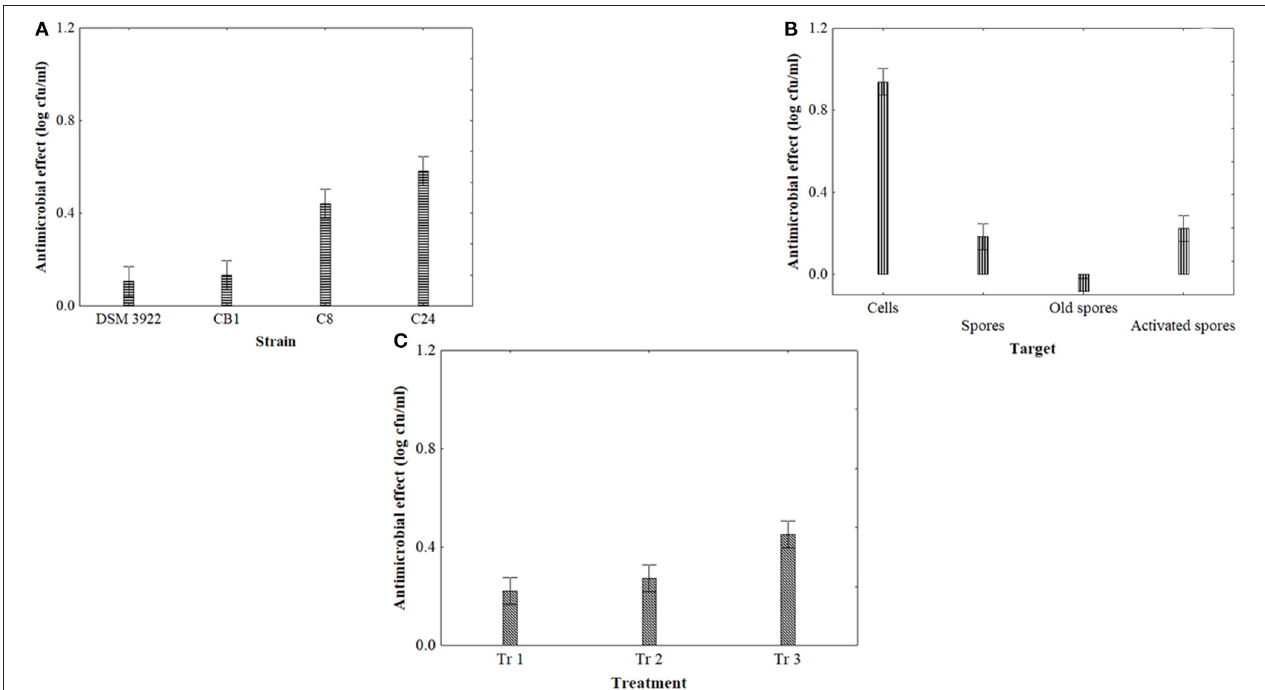
FIGURE 3 | Decomposition of the statistical hypothesis of ANOVA for the effect of US on the antimicrobial effect (reduction of viable count, log cfu/ml) of A. acidoterrestris . Vertical bars denote the 95% confidence intervals. (A) , effect of strain; (B) , effect of target; (C) , effect of the treatment (tr 1, 40% 6min 4s; tr 2, 60% 6min 4s; tr 3, 40% 8min